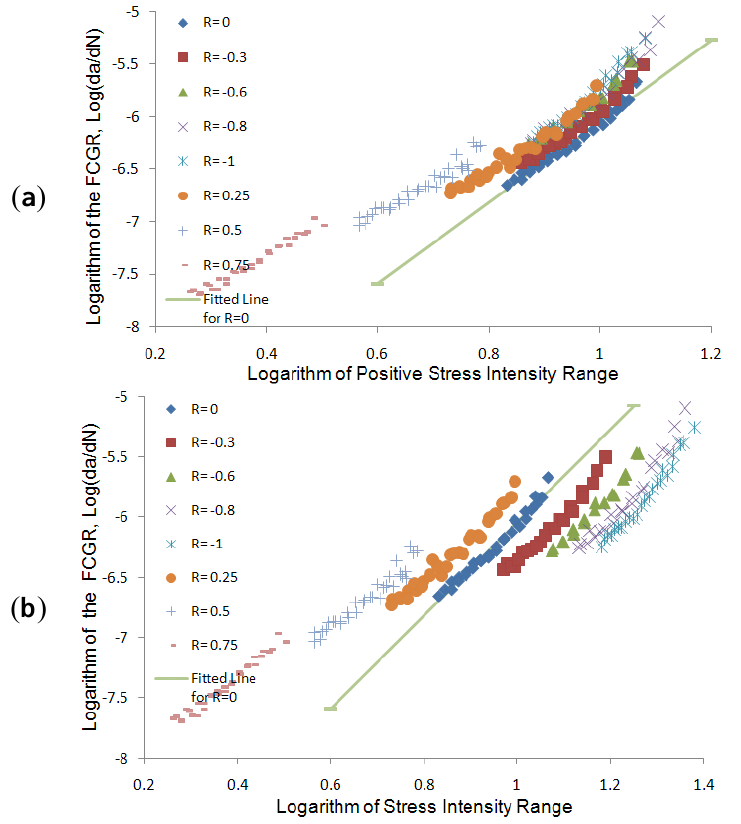
intensity range; and ( b ) the whole stress intensity range [26].